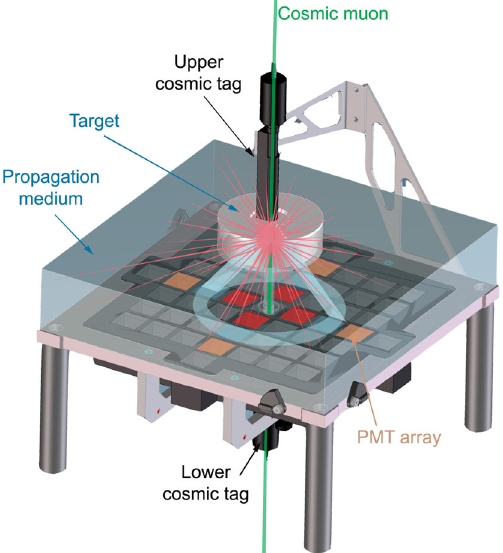
Fig. 5 Configuration for the Cherenkov and scintillation separation study with cosmic muons. The detected Cherenkov rings are expected to lay on the middle PMTs, highlighted in blue. See Sect. 4.1 for a more detailed description. In the same fashion than Fig. 1, the scintillator panels are not drawn and their layout can be seen in